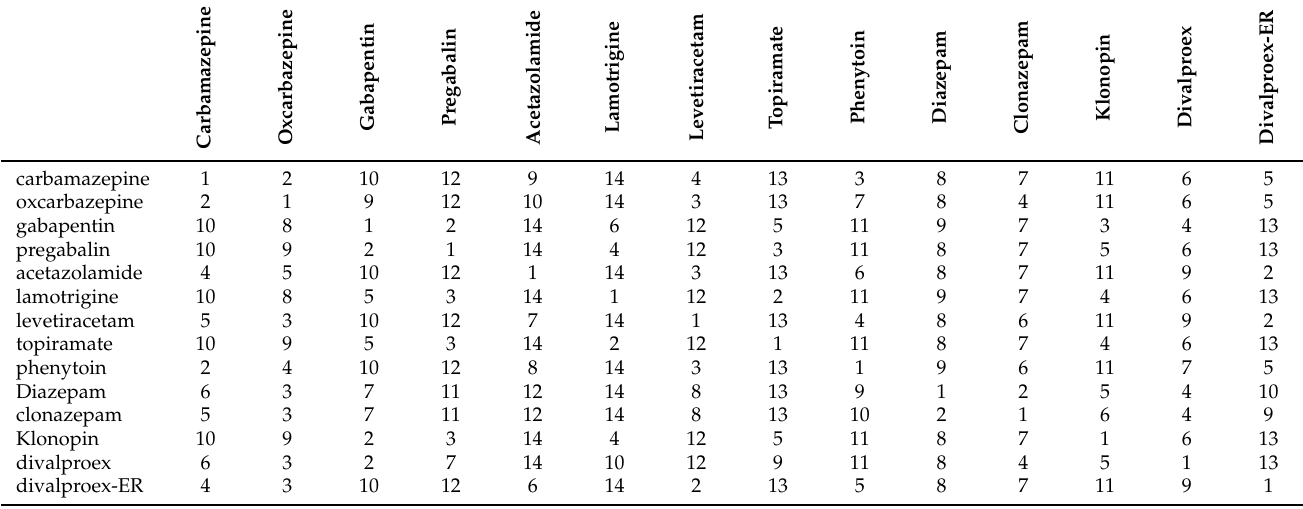
Table 9. AEDs Drug-Drug Similarity-based Rankings using JC